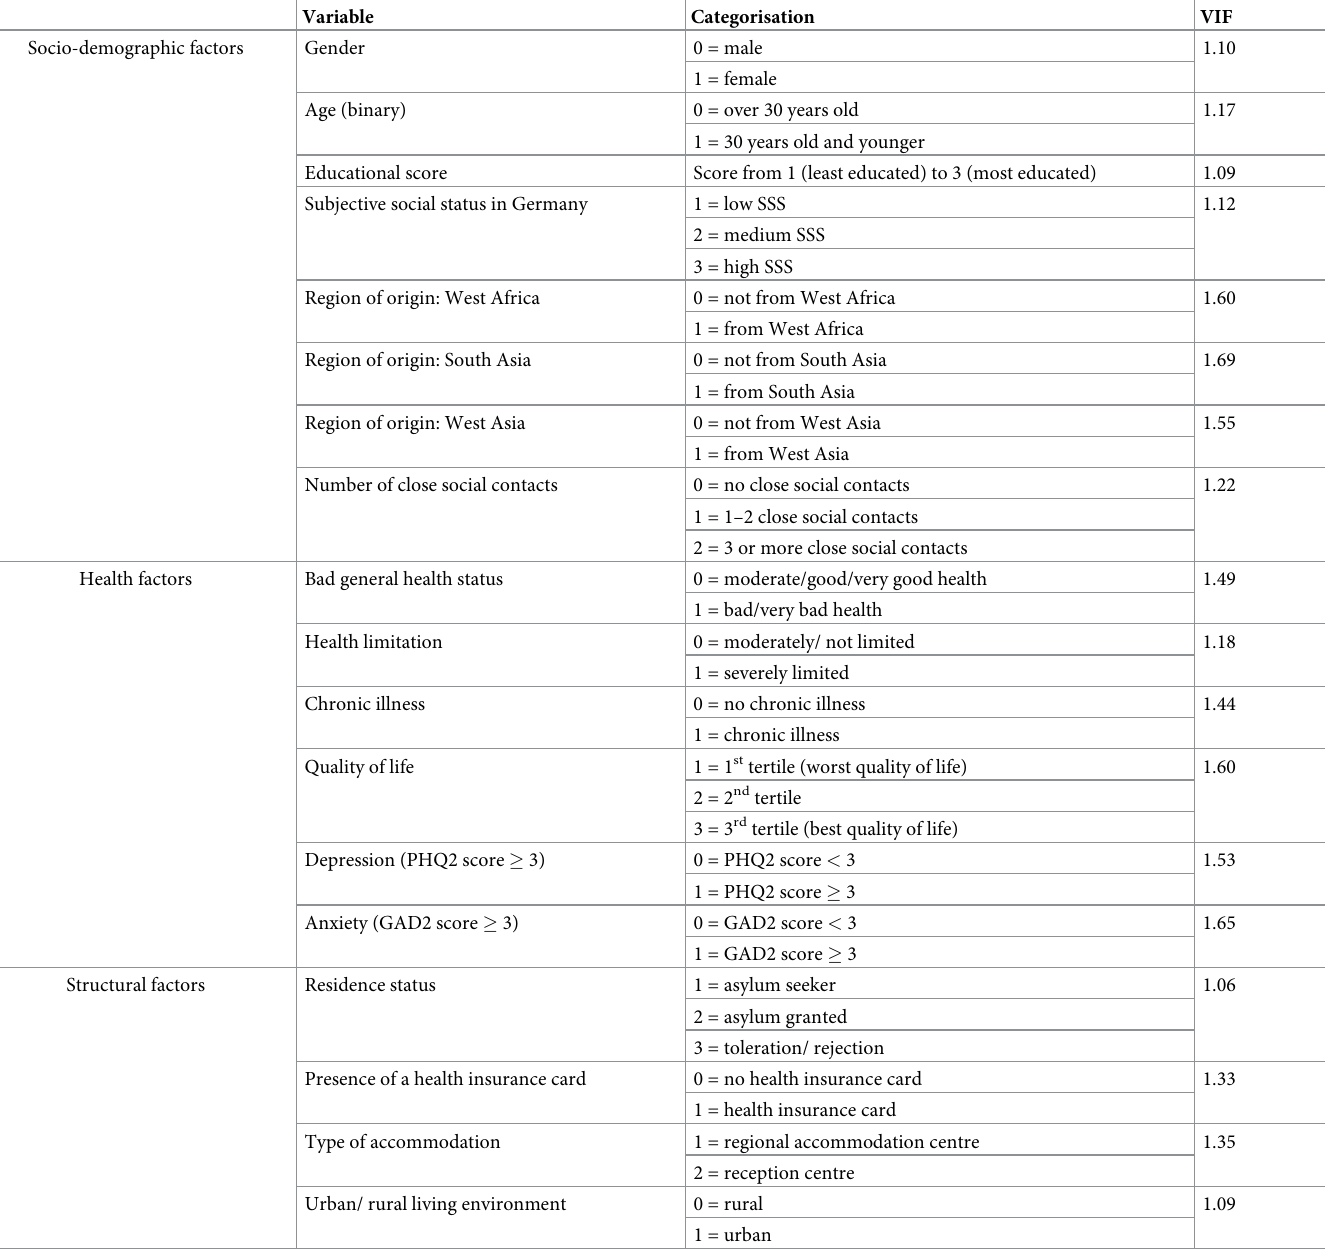
Table 1. Socio-demographic, health and structural factors included in the analysis of inequities of